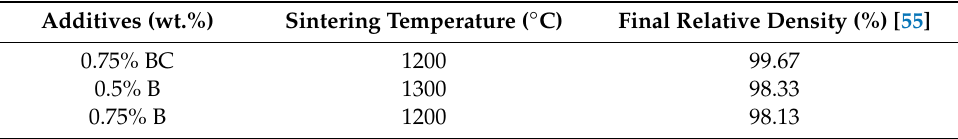
Table 11. 316L SS sintered samples with the highest final relative density. Additives (wt.%)